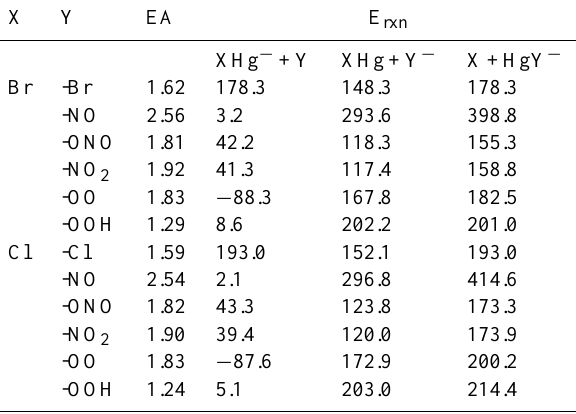
Table 4. XHgY electron affinities (EA, eV) and reaction energies for anion dissociation (E rxn , kJmol − 1 ) at a temperature of 0K using CCSD(T)/aVTZ single point energies computed with B3LYP/aVTZ structures and zero-point energy corrections. A negative number in- dicates the fragments are more stable than the XHgY